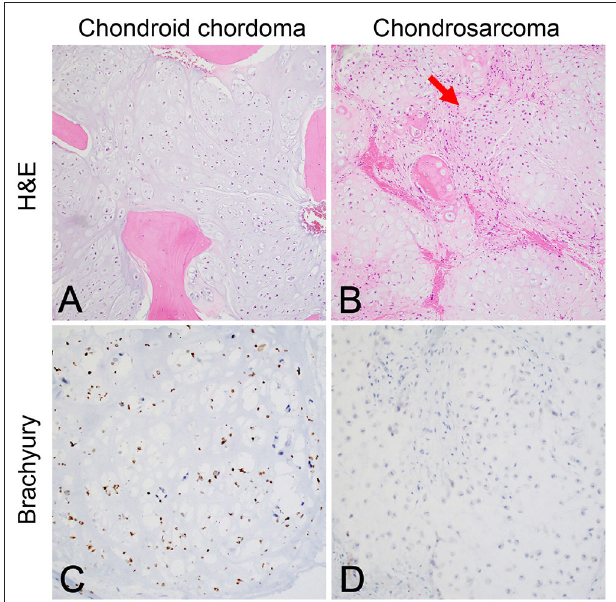
FIGURE 2 | (A) Chondroid chordoma characteristically contains regions forming hyaline cartilage with tumor cells distributed individually in lacunar spaces that greatly resemble (B) low-grade chondrosarcoma, which classically feature hypercellular hyaline cartilage lobules with a permeative growth pattern. Chondrosarcomas of the skull base in particular have variably prominent myxoid areas (arrow) that resemble chondroid chordoma. (C) Brachyury nuclear positivity confirms the diagnosis of chordoma, while being (D) consistently negative in